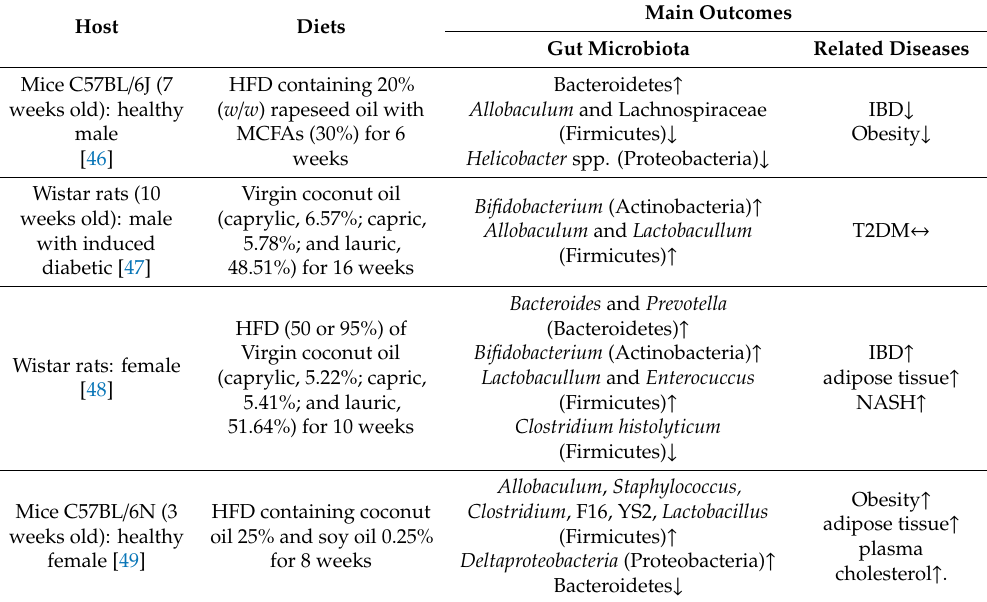
Table 1. E ff ects of medium-chain fatty acid intake on gut microbiota composition and metabolic outcomes in animal